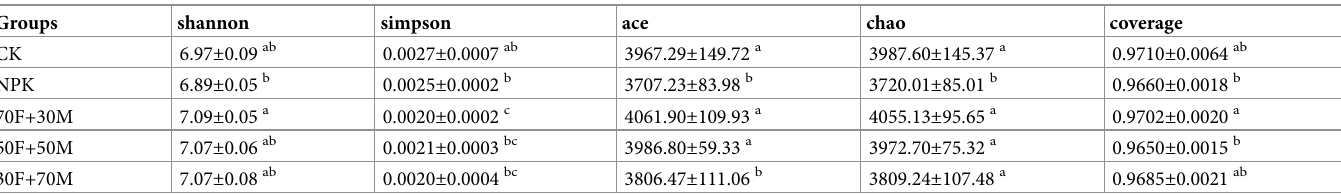
Table 3. Alpha diversity index of bacteria in different groups.